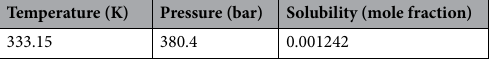
Table 3. Optimal